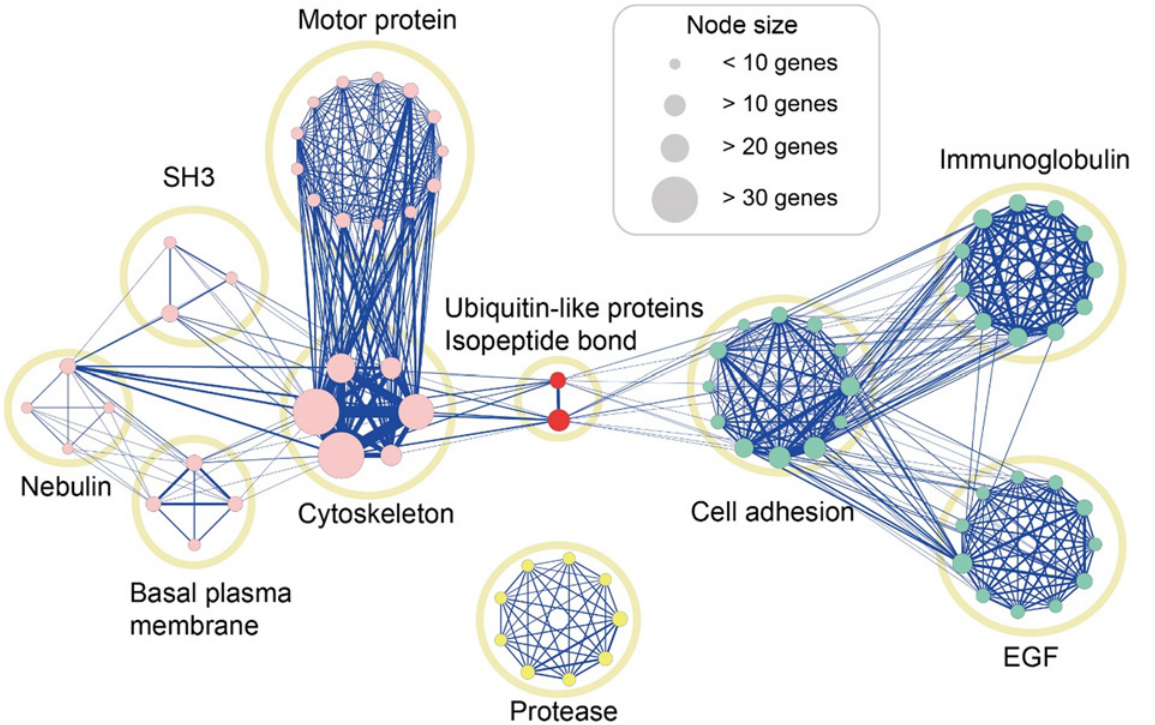
Fig 2. Analysis of gene function enrichment and construction of functional network. Each cluster is represented as a yellow circle, in which nodes show all terms included in the cluster. A representative term was selected to describe each cluster. Node size shows the number of genes mapped in the network. Nodes were color-coded according to their characteristics: genes related to cell morphology (pink), cell adhesion and binding (green), Ubiquitin-like proteins and isopeptide bond (red), and proteases (yellow). If different terms share two or more genes, a link was given. Links express the number of genes shared among distinct